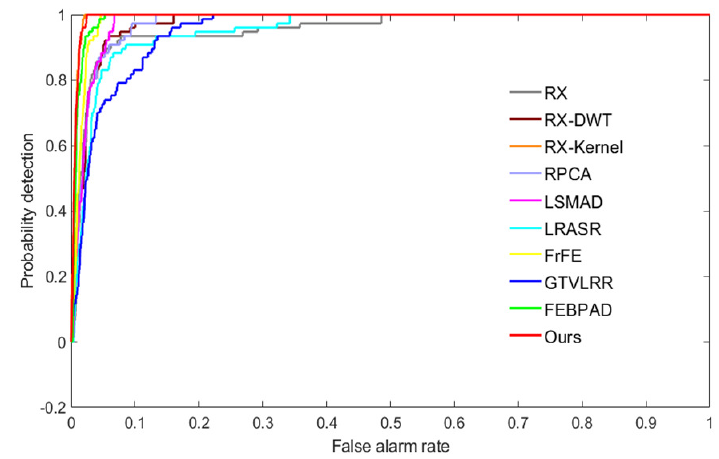
Figure 8. ROC curves of anomaly detectors on the AVIRIS-II dataset.